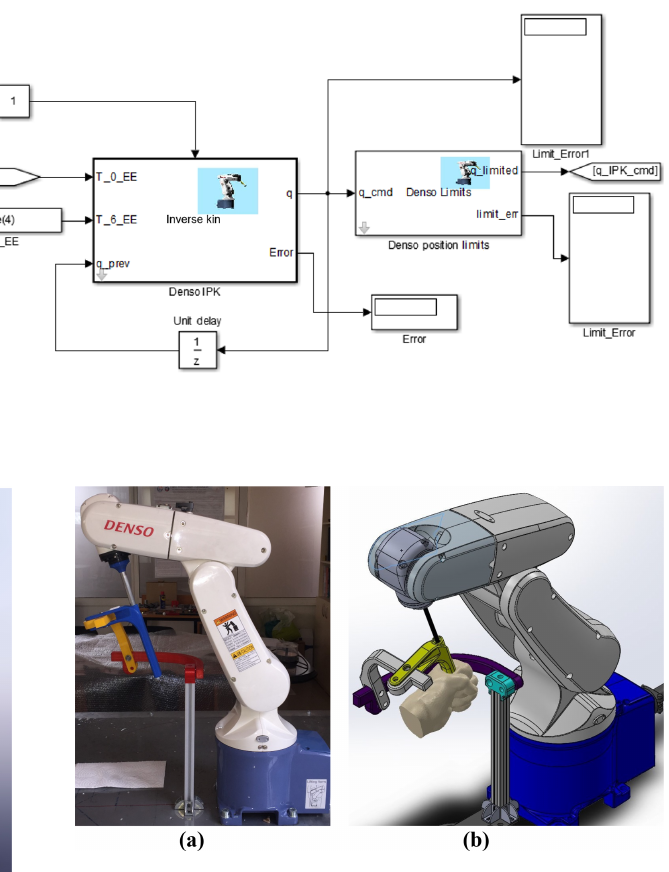
Figure 8. Limit condition of the fifth